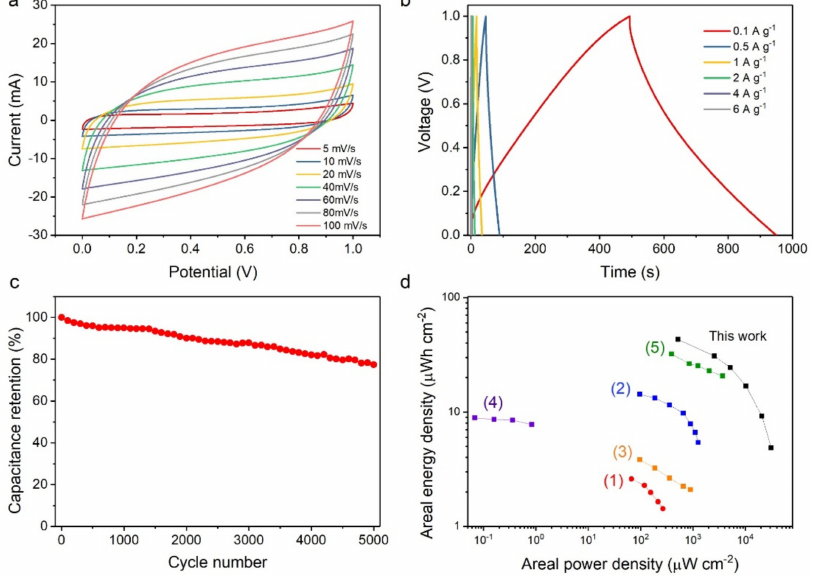
Figure 6. ( a ) CV curves of GTPC-1-based solid-state supercapacitor at various scan rates. ( b ) Dis- charge curves of GTPC-1-based solid-state supercapacitor at different current densities. ( c ) Cycling stability of the solid-state supercapacitor for 5000 cycles at a current density of 1 A g − 1 . ( d ) Compari- son of our solid-state supercapacitor with previous reported solid-state supercapacitors from related literature ((1) Carbon nanotube/MnO 2 /polymer fiber [33], (2) polyaniline/polyvinyl alcohol (PANI– PVA) composite hydrogel [34], (3) reduced graphene oxide(RGO) + carbon nanotube(CNT)@ceramic matrix composites fibers [35], (4) Ag–Doped poly(3,4-ethylenedioxythiophene) polystyrene sul- fonate/CNT composites [31], and (5) Mn 3 O 4 /RGO/single-walled CNT hybrid film-based solid-state supercapacitor